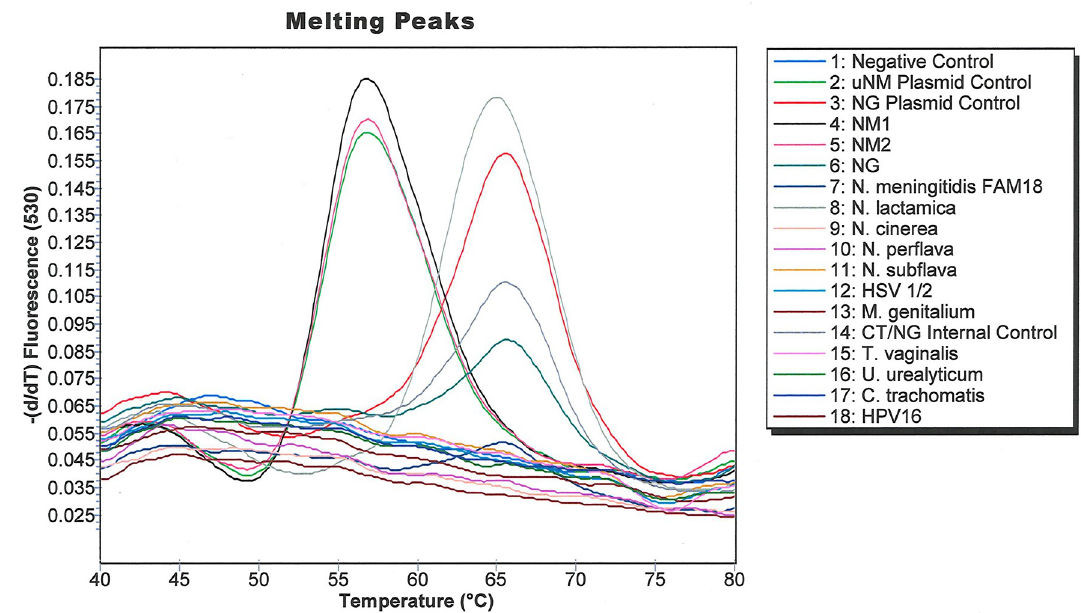
Fig 2. Amplification curves generated when the SimpleProbe 1 US_NmUC assay was tested against various microorganisms that can colonize the urogenital tract.